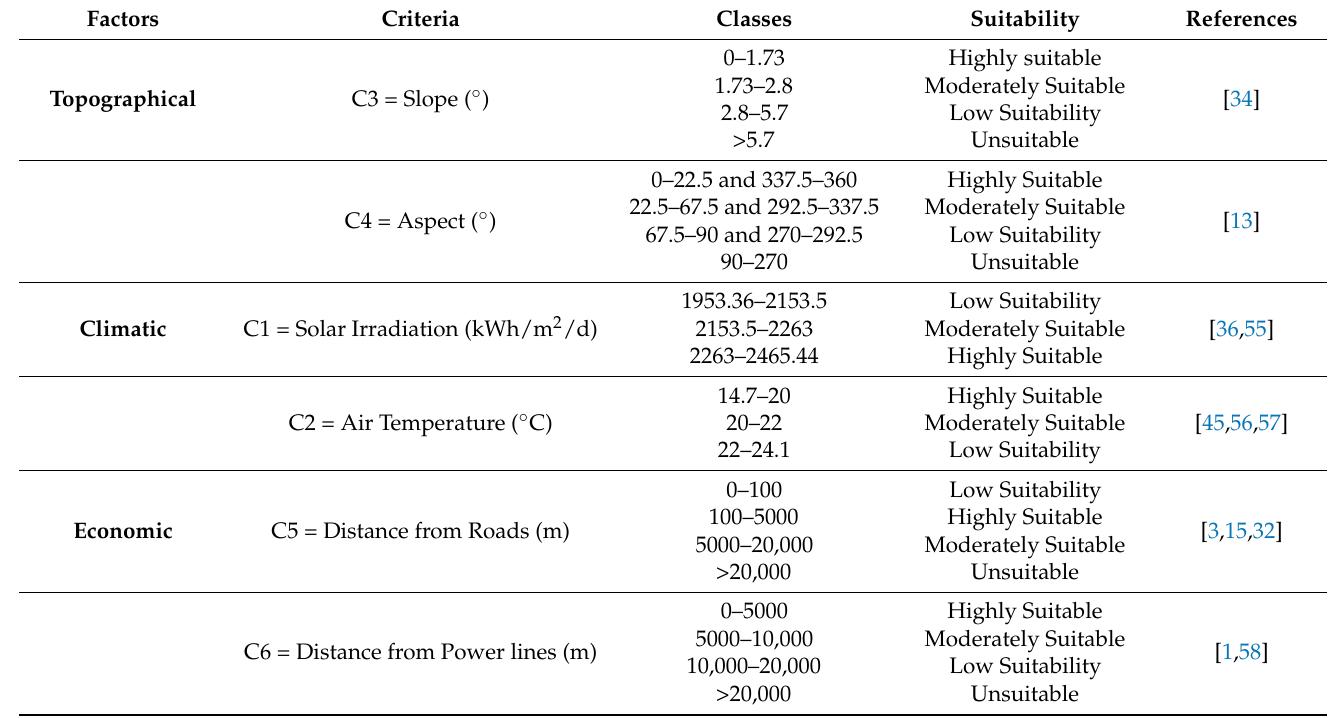
Table 5. Factors involved in installing solar PV systems.